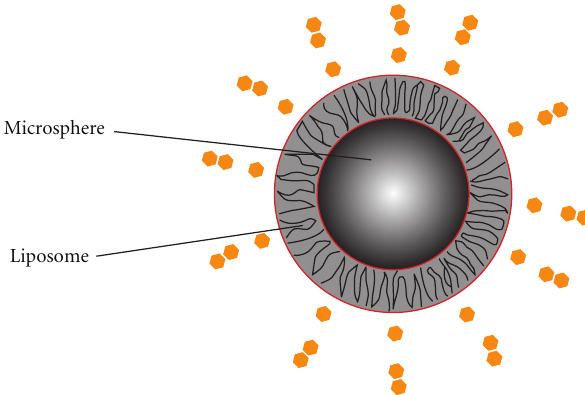
Figure 8: Microspheres (or nanospheres) within